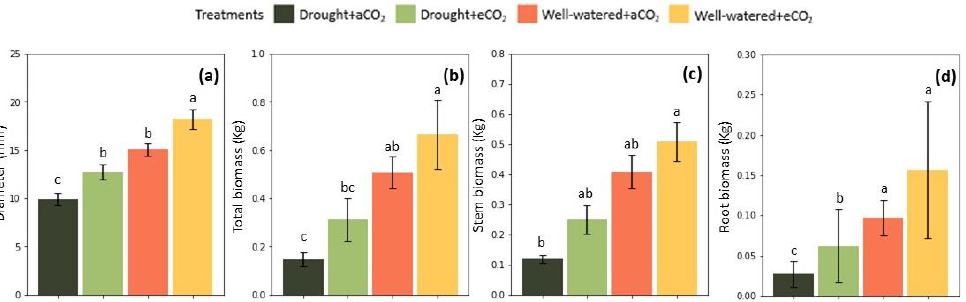
Figure 5. Effect of elevated CO 2 (950 ppm) and cyclic drought stress in the mean value (± confidential level of 95%) of Eucalyptus grandis ( a ) stem diameter, ( b ) total biomass, ( c )stem biomass, and ( d ) root biomass at the end of the growing season. Different small letters indicate statistical significance between the means ( p < 0.05).